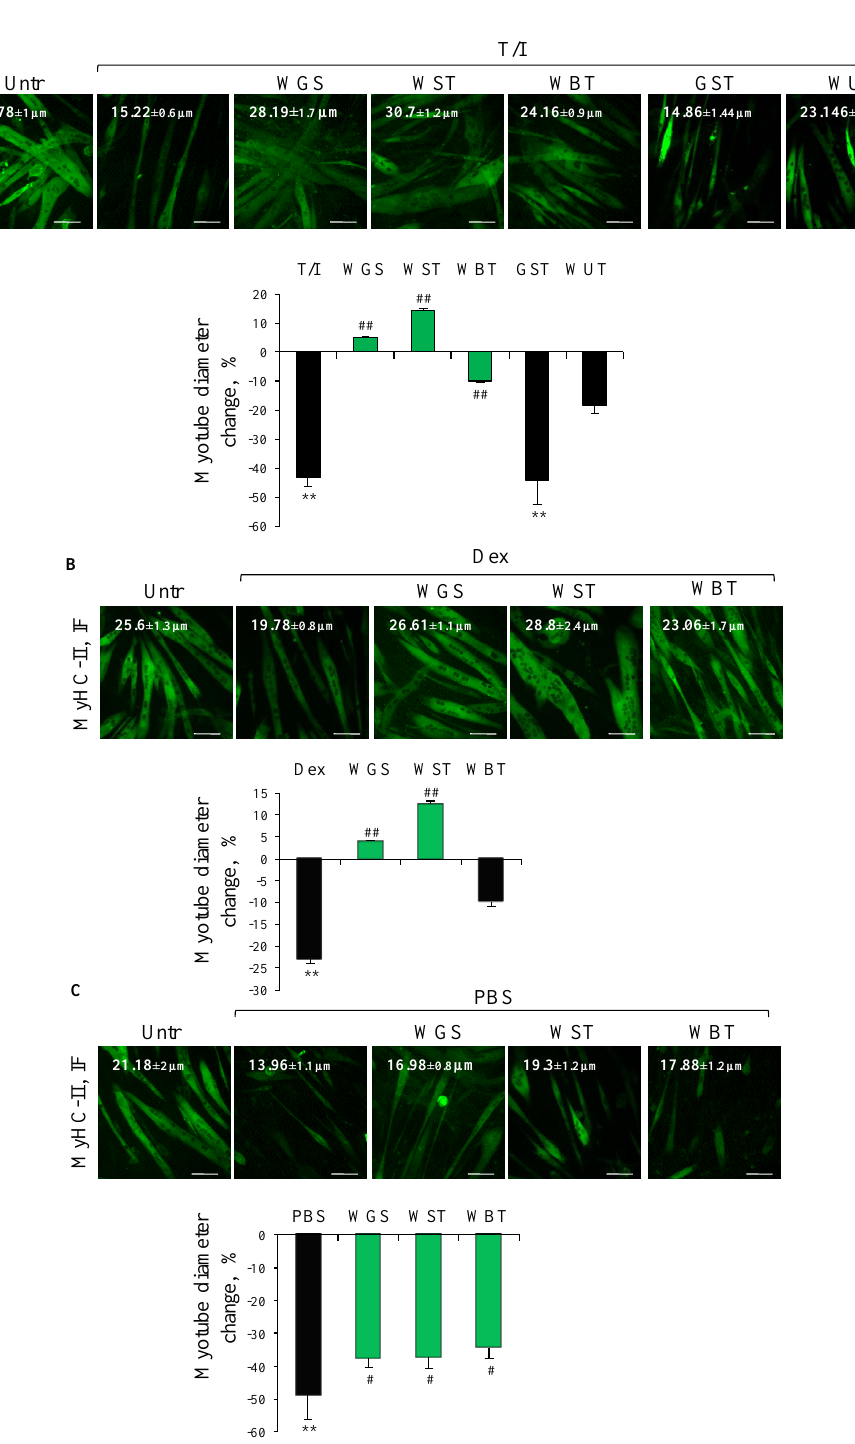
Figure 3. ( A – C ) The best formulations were tested (100 µg/mL) on C2C12 myotubes treated or not with TNFα (tumor necrosis factor α, 20 ng/mL)/IFNγ (interferon γ, 100 U/mL) (T/I) or dexamethasone (Dex, 1 µM) , or starved with PBS (phosphate buffered saline). After 48 h or 16 h (PBS), immunofluorescence (IF) staining for myosin heavy chain (MyHC)-II was per- formed and myotube diameters were measured. Reported are representative images with myotube diameters ( µ m) and the percent changes of myotube diameters with respect to untreated control. The green bars represent the formulations able to protect against myotube atrophy induced by different stimuli. Results are means ± SEM (standard error of the mean) ( A – C ). Statistical analysis was conducted using t -test ** p < 0.01 significantly different from untreated control; # p < 0.05 and ## p < 0.01 significantly different from T/I ( A ), Dex ( B ) or PBS ( C ). Bars, 100 µ